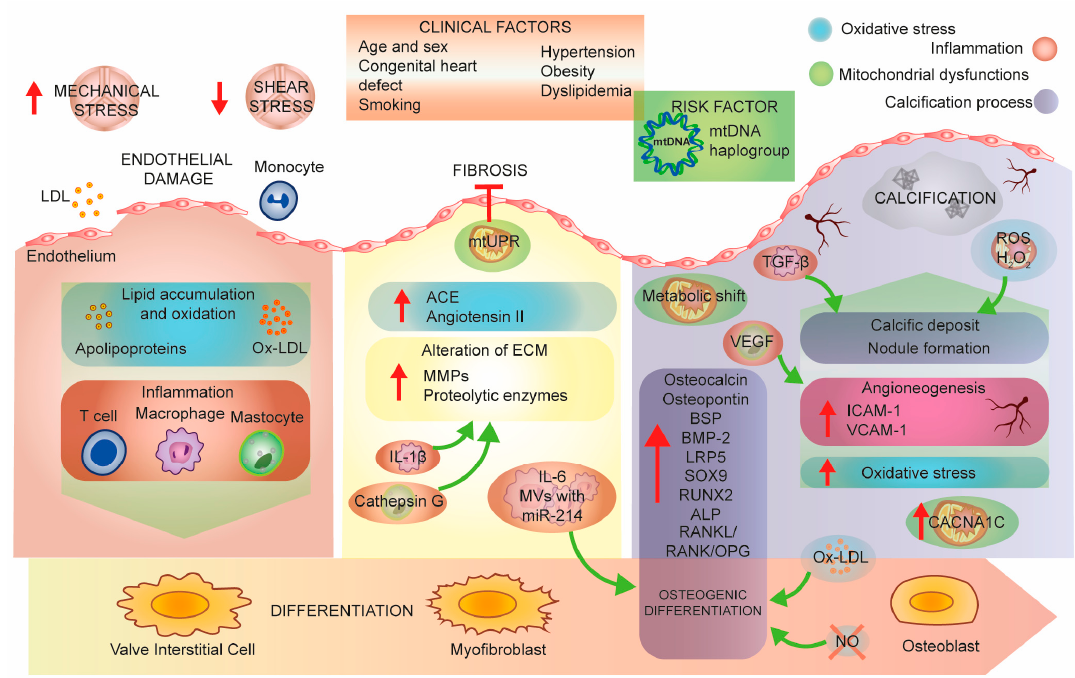
Figure 2. Aortic stenosis pathobiology: a molecular perspective. Mechanical and shear stress induces endothelial damage that leads to lipid accumulation and increased inflammation in valve tissue. These physiological impairments lead to fibrotic processes and to a step-by-step di ff erentiation of valve interstitial cells to myofibroblasts and finally osteoblasts. The final stage of the disease is the calcification of the tissue. Abbreviations: LDL, low-density lipoprotein; oxLDL, oxidized low-density lipoprotein; mtUPR, mitochondrial unfolded protein response; ACE, angiotensin-converting enzyme; ECM, extracellular matrix; MMPs, matrix metalloproteinases; MVs, microvesicles; TNF- α , tumor necrosis factor α ; BSP, bone sialoprotein; BMP-2, bone morphogenetic protein-2; LRP5, LDL receptor-related protein 5; SOX9, SRY-box 9; RUNX2, runt-related transcription factor 2; ALP, alkaline phosphatase; RANKL, receptor activator of NF-kappa B ligand; RANK, receptor activator of nuclear factor κ ; OPG, osteoprotegerin; NO, nitric oxide; VEGF, vascular endothelial growth factor; TGF- β , transforming growth factor beta; ROS, reactive oxygen species; ICAM-1, intercellular adhesion molecule 1; VCAM-1, vascular cell adhesion molecule-1; CACNA1C, calcium voltage-gated channel subunit alpha 1